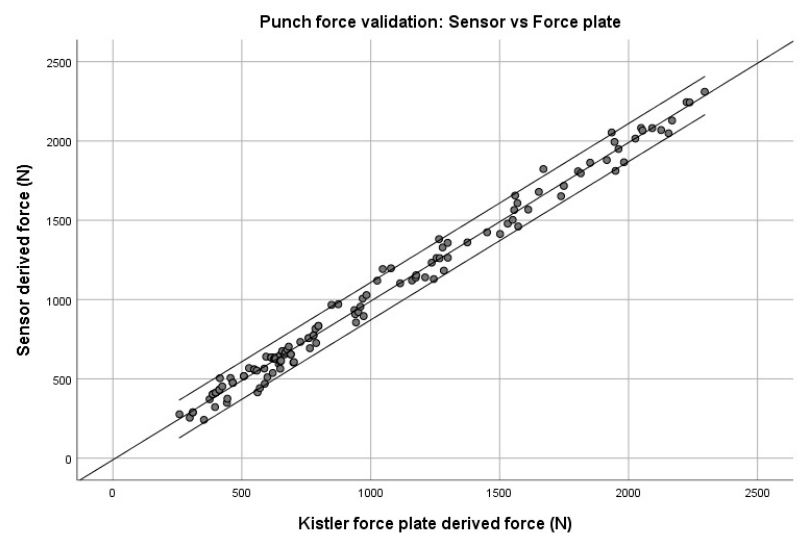
Figure 4. Punch force validation: Sensor-derived force (N) vs. Force plate-derived force (N). To further analyze the impact force, the time force progression of the punch force determined with the sensor (green) was analyzed with respect to the force time progression measured by the force plate (black). This analysis shows a correlation of the force–time curves of R = 0.98. The sensor-derived force-time curve shows a symmetrical leptokurtic curve pattern by comparison with the Kistler force plate-derived force-time profile in Figure 5.